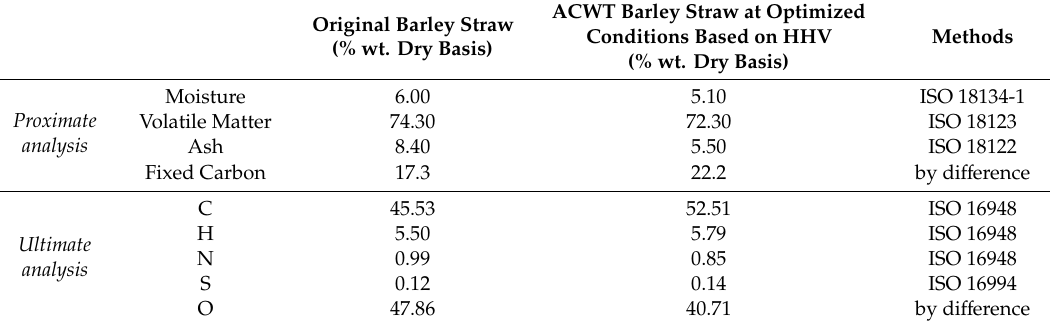
Figure 3. HHV vs. CSF in logarithmic form. Table 3. Proximate and ultimate analysis of the original and ACWT-treated (at optimized conditions based on HHV) barley straw.